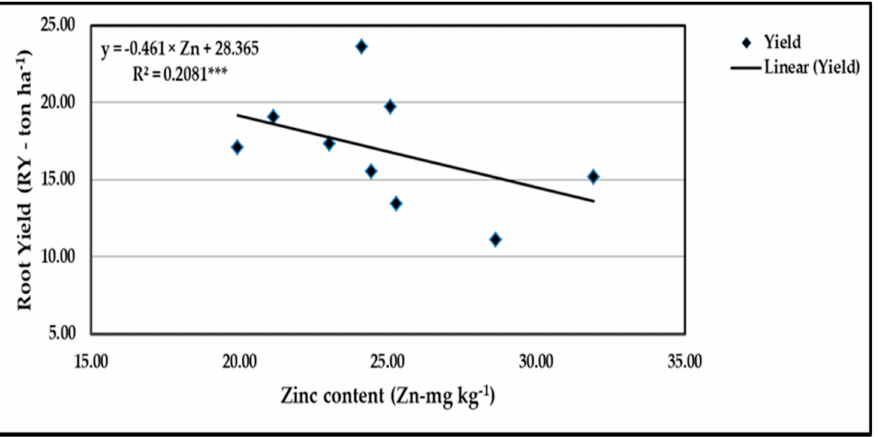
Figure 20. Contribution of Zn content to the quadratic response of stressed sweet potato to different levels of ascorbic acid and zinc oxide nanoparticles in the 2020 season. *** indicates differences at p ≤ 0.001 probability level.